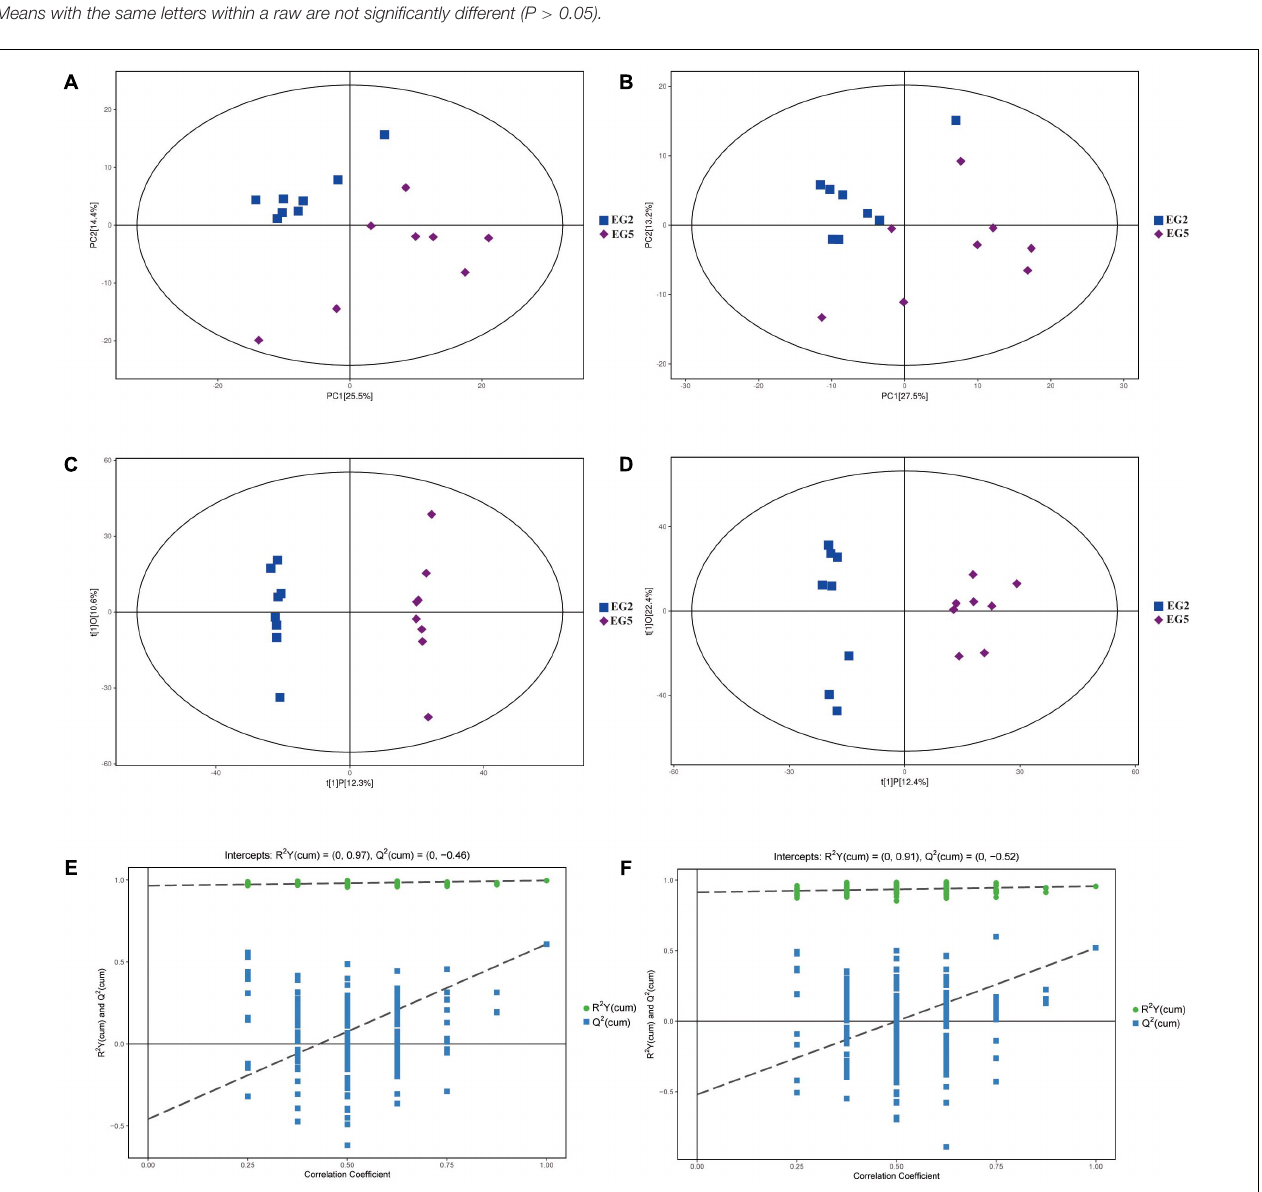
FIGURE 1 | PCA model score scatter plot, OPLS–DA model, and permutation test for groups EG2 and EG5. The PCA model (A,B) , OPLS–DA model (C,D) , and permutation test of the OPLS–DA model (E,F) were derived from the UHPLC–QTOF/MS metabolomics profiles. (A,C,E) were derived from the POS ion mode, and (B,D,F) were derived from the NEG ion